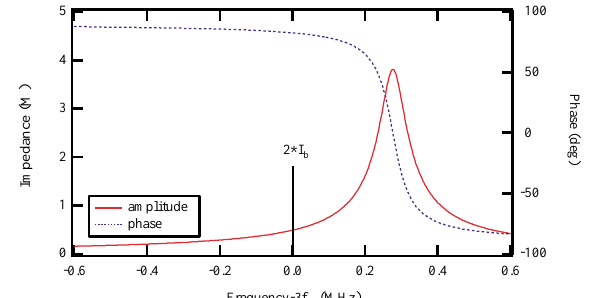
FIG. 3. (Color) rf bucket with and without harmonic voltage and optimum flattening. The rf acceptance is reduced slightly with the harmonic voltage reducing the lifetime increase from the bunch lengthening.